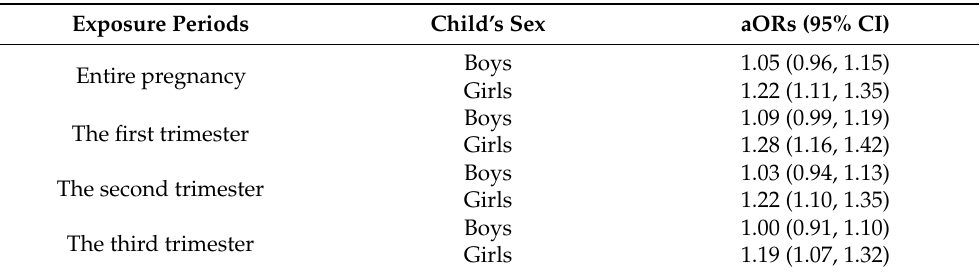
Table 3. Adjusted associations of PTB with maternal MCS exposure during different periods of pregnancy, stratified by the child’s sex #